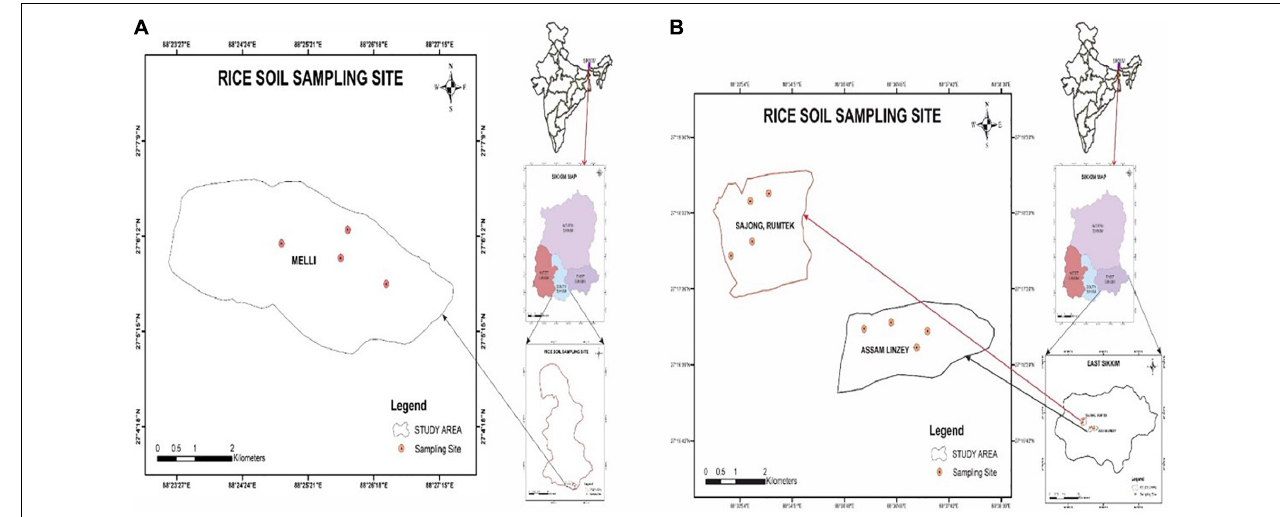
FIGURE 1 | Location of the sampling sites (A) South and (B) East Sikkim,